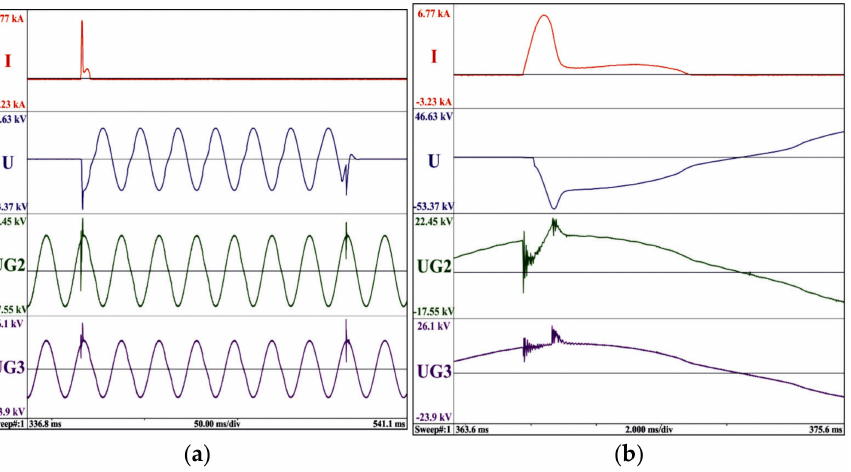
Figure 10. ( a ) Oscillogram obtained for the making angle of short-circuit current of 75 electrical degrees; ( b ) connection detail in the oscillogram. Table 7. Values obtained in I 1 series of